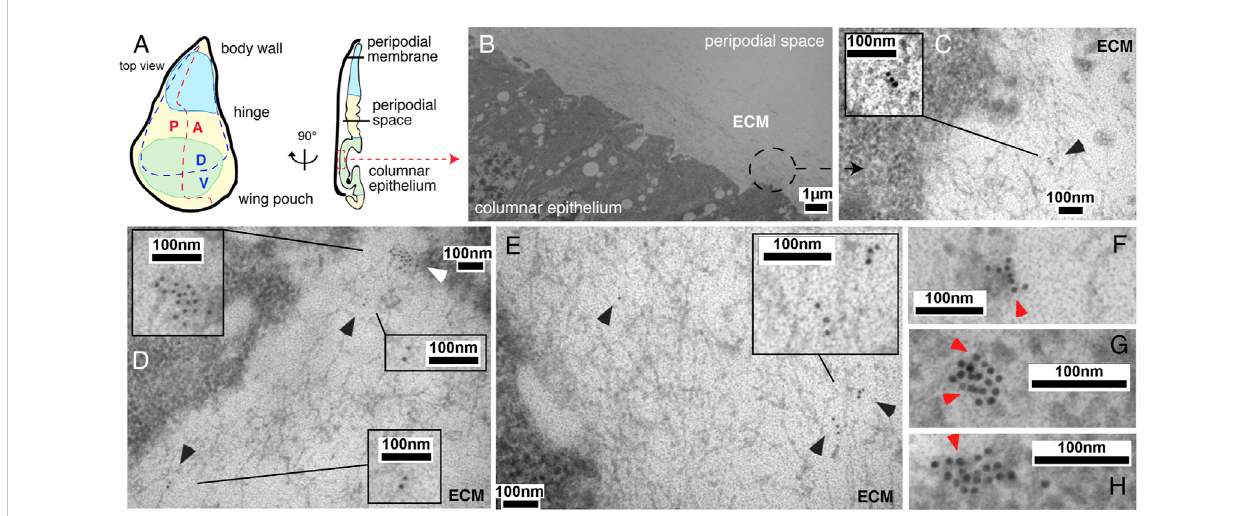
FIGURE 1 IEManalysis ofShhclustersatthewingdiscsurfaceorassociatedwiththeextracellularmatrix. (A) Schematic ofthe Drosophila wingdisc.The discis dividedalongtheproximal-distalaxisintoregionsgivingrisetothebodywall(inblue,proximal),winghinge(central)andwingpouch(ingreen,distal).This distal region contains cells of the peripodial membrane and the columnar epithelium that forms the adult wing blade. A fl uid- fi lled peripodial space divides these cell types. Dorsal/ventral (D/V) and anterior/posterior (A/P) compartments are indicated. (B) Using the Gal4/UAS system, Shh was produced in the posterior wing disc compartment under engrailed (en) control. Transmission electron micrograph of the apical columnar wing disc epithelium and overlying peripodial space. ECM: fi brillar extracellular matrix meshwork. (C – E) Anti-Shh immunogold labeling detects untagged Shh closely associated with the fi brillar extracellular meshwork overlaying the epithelial surface (black arrowheads). Larger cell surface-associated Shh aggregates that give rise to the mobile Shh clusters were also detected [ (D) , white arrowhead]. (F – H) Shh appears to be predominantly arranged non- randomly in cell surface-associated aggregates (red